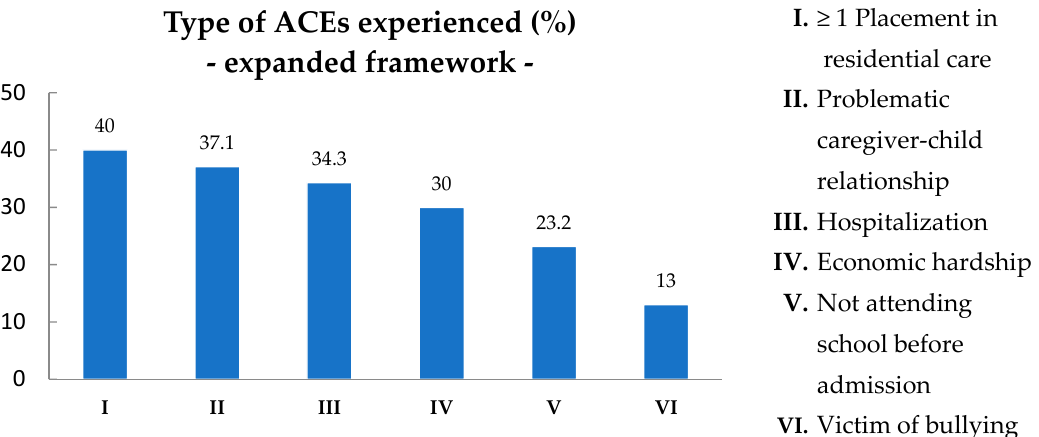
Figure 4. Type of ACEs experienced (%) from the expanded ACEs framework in children with ID, n = 69.